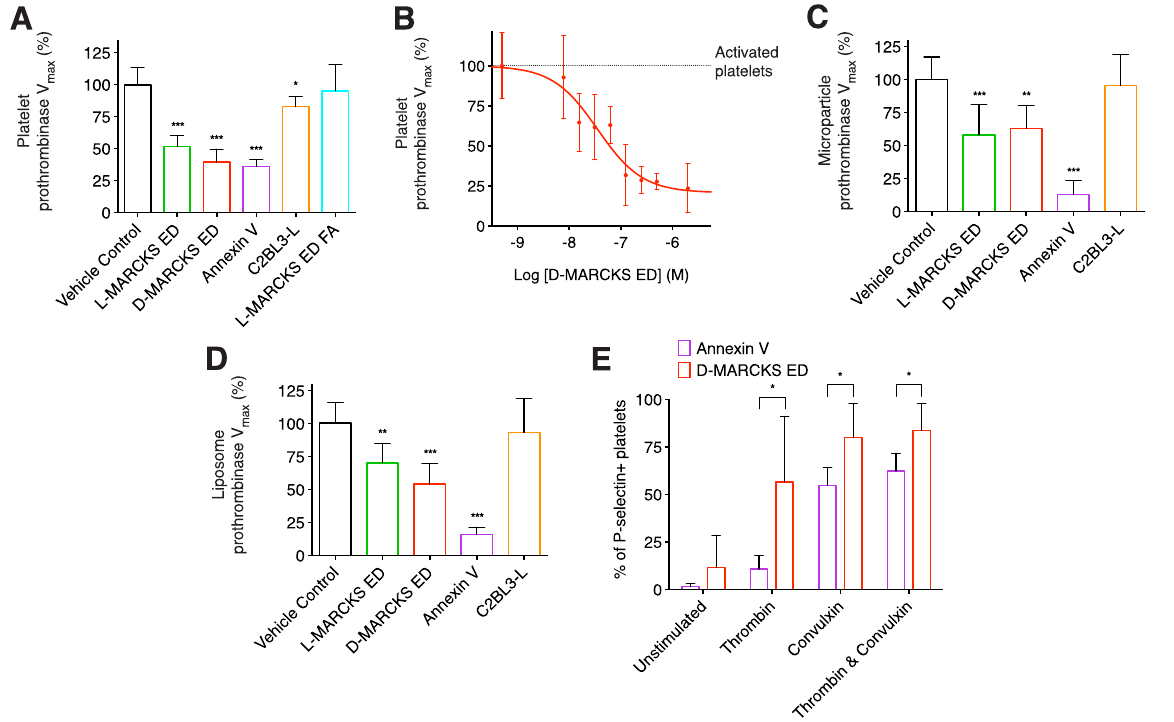
Figure 2. MARCKS ED inhibits prothrombinase enzymatic activity in the presence of PS containing membranes and only binds to activated platelets. ( A ) Prothrombinase activity of washed human platelets stimulated with thrombin and convulxin when pre-treated with vehicle control or 1 μ M L-MARCKS ED, D-MARCKS ED, positive control annexin V, negative control C2BL3-L, or negative control L-MARCKS ED FA mutant ( n = 8, mean ± SD). ( B ) Dose response of D-MARCKS ED pre-treatment on the prothrombinase activity of washed human platelets stimulated with convulxin and thrombin ( n = 4, mean ± SD). ( C ) Prothrombinase activity of exosomes isolated from MDA-MB-231 cells when pre-treated with vehicle control or 1 μ M L-MARCKS ED, D-MARCKS ED, annexin V, or C2BL3-L ( n = 8, mean ± SD). ( D ) Prothrombinase activity of synthetic liposomes composed of POPC/POPS at a 19/1 ratio when pre-treated with vehicle control or 1 μ M L-MARCKS ED, D-MARCKS ED, annexin V, or C2BL3-L ( n = 8, mean ± SD). ( E ) The binding of annexin V (Brilliant Violet 605) and D-MARCKS ED (NBD) to P-selectin (Cy5) positive platelets was compared by flow cytometry when the platelets were left unstimulated or stimulated with thrombin, convulxin, or thrombin and convulxin ( n = 6, mean ± SD). * P < 0.05, ** P < 0.01, *** P < 0.001 either by comparison to vehicle control by ANOVA followed by Dunnet’s post hoc test ( A , C , D ) or two tailed Student’s t -test ( E